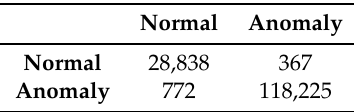
Table 15. Confusion matrix for Bagging